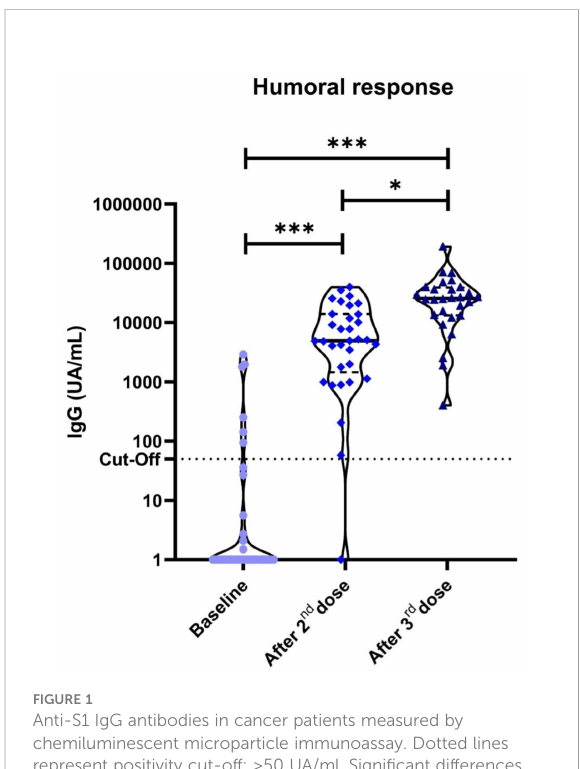
FIGURE 1 Anti-S1 IgG antibodies in cancer patients measured by chemiluminescent microparticle immunoassay. Dotted lines represent positivity cut-off: ≥ 50 UA/ml. Signi fi cant differences were observed in our cohort of cancer patients between the baseline anti-S1 titres and after the second ( p <0.001) and third vaccine doses ( p <0.001). * P <0.05 ** P <0.01 *** P